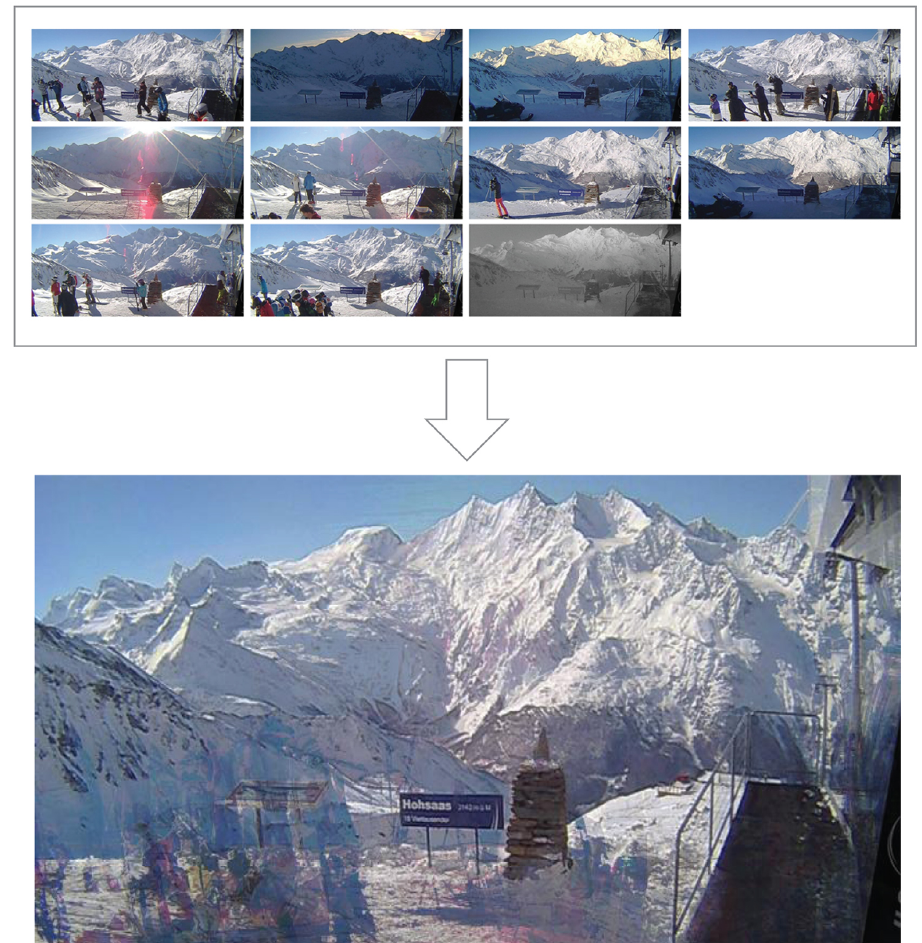
Figure 2. Example of Daily Median Image obtained from 11 images acquired in the same